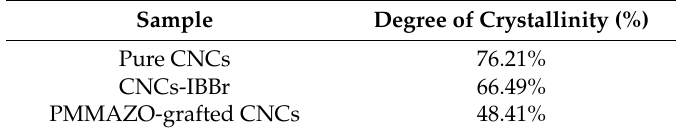
Table 2. The degree of crystallinity for Pure CNCs, CNCs-IBBr, and PMMAZO-grafted CNCs.